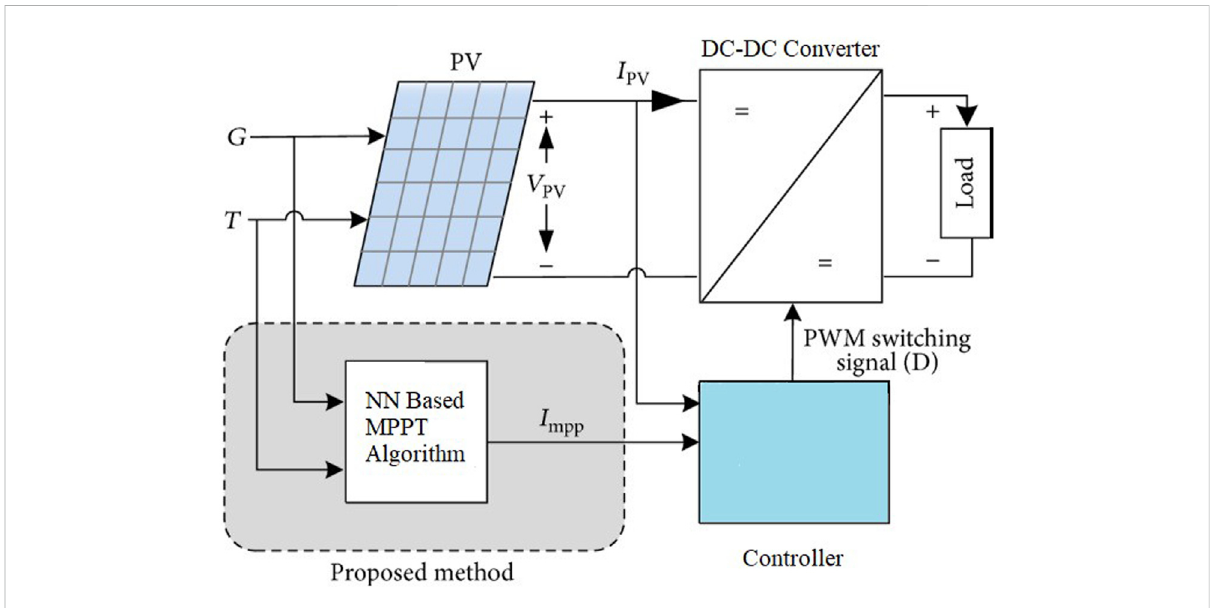
FIGURE 1 Block diagram for the entire system of the proposed